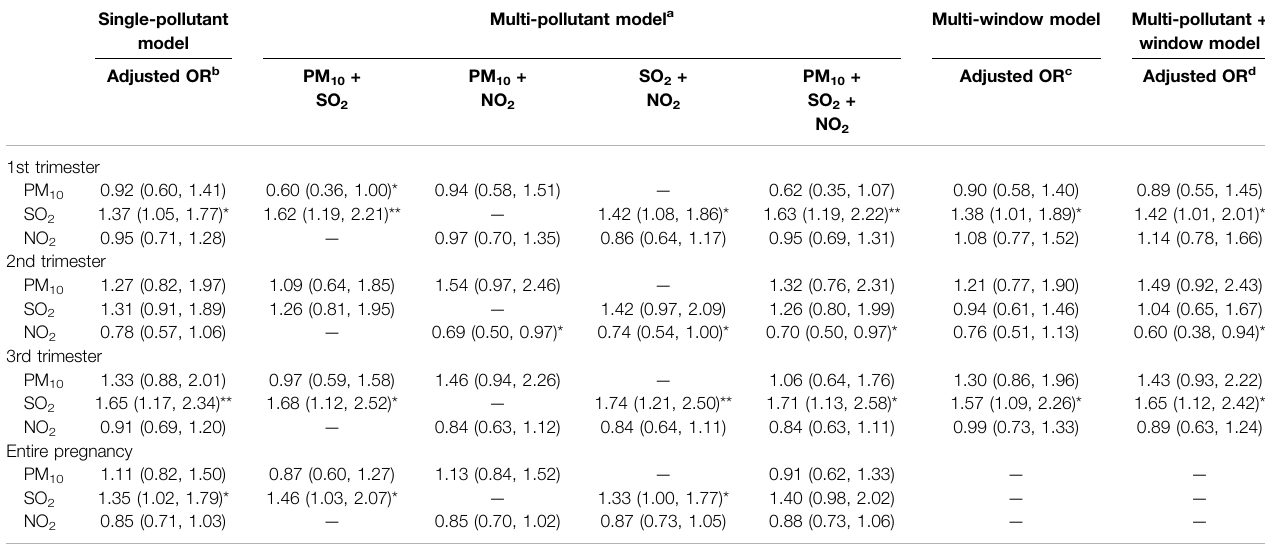
b Single adjusted model: Model adjustment was performed speci fi c to all the covariates in Table 1 as well as the outdoor air temperature in different time window. c Multi-window model: Model adjustment was performed speci fi c to the same pollutant in the other time window on the basis of the single adjusted model. d Multi-pollutant + window model: Models adjustment was performed speci fi c to the same pollutant in the other time windows on the basis of the multi-pollutant model. * p ≤ 0.05. ** p ≤ 0.01.